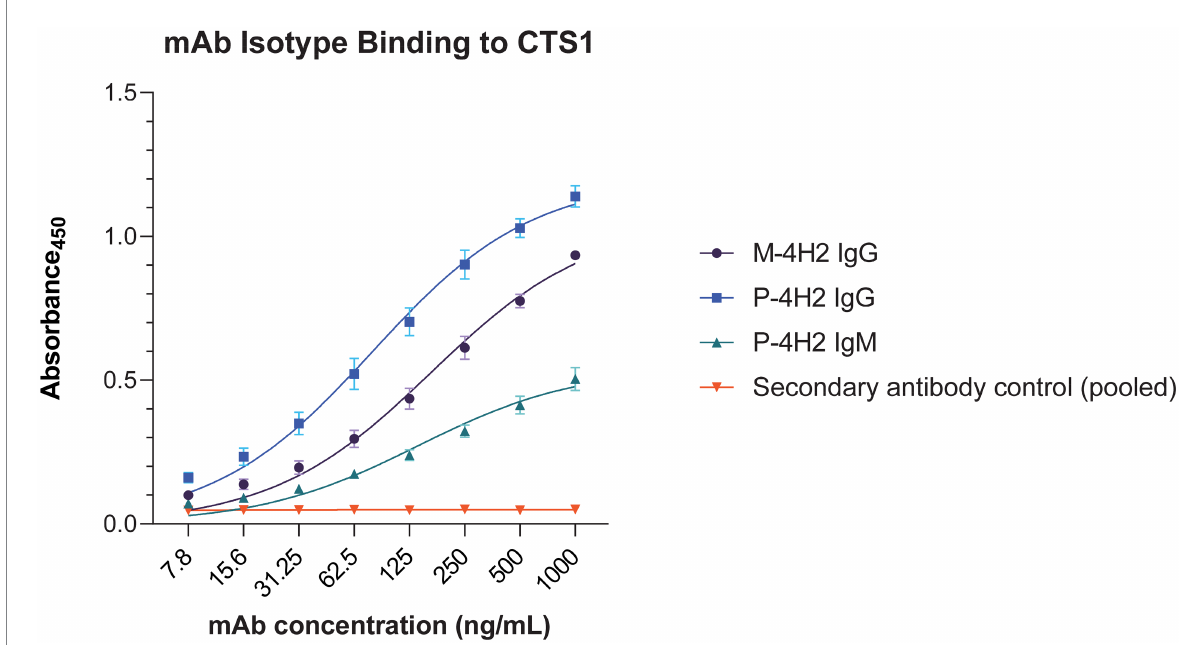
FIGURE 5 Plant-Made 4H2 Isotypes Specifically Bind to Target Antigen. Serial dilutions of P-4H2 IgG and P-4H2 IgM isotypes were incubated with CTS1 immobilized on ELISA plates. An HRP-conjugated anti-human IgG or anti-human IgM secondary antibody was used to detect the specific interaction between the plant-made IgG or IgM isotype (P-4H2 IgG, P-4H2 IgM) with CTS1, respectively. The parental mouse IgG (M-4H2 IgG) was used as a positive control, which was detected with an anti-mouse IgG secondary antibody conjugated to HRP. Mean ± SEM is plotted from three independent experiments.